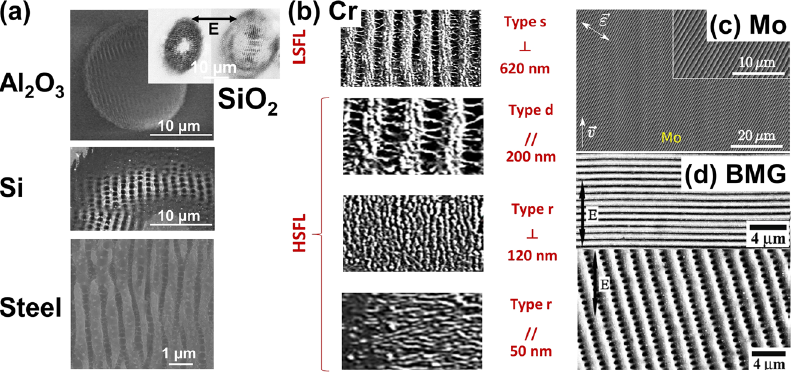
Figure5: (a)Top:Regularripplesondielectrics.Asapphire(corundum)surfaceirradiatedwithmultipulsepslaserradiationslightlyabovethe ablation threshold is shown. Inset: examples of parallel and perpendicular close-to-wavelength ripples on fused silica upon irradiation with few 200 fs pulses at two different fl uence regimes, low (left) and high (right). Middle: Ripples on silicon. Bottom: Ripples on stainless steel. (b) Multitude of periodicities and orientations observed on chromium, classifying the types of currently observed laser-induced periodic surface structures (LIPSS) [92]. (c) High order arrangement on molybdenum. Reprinted with permission from a study by